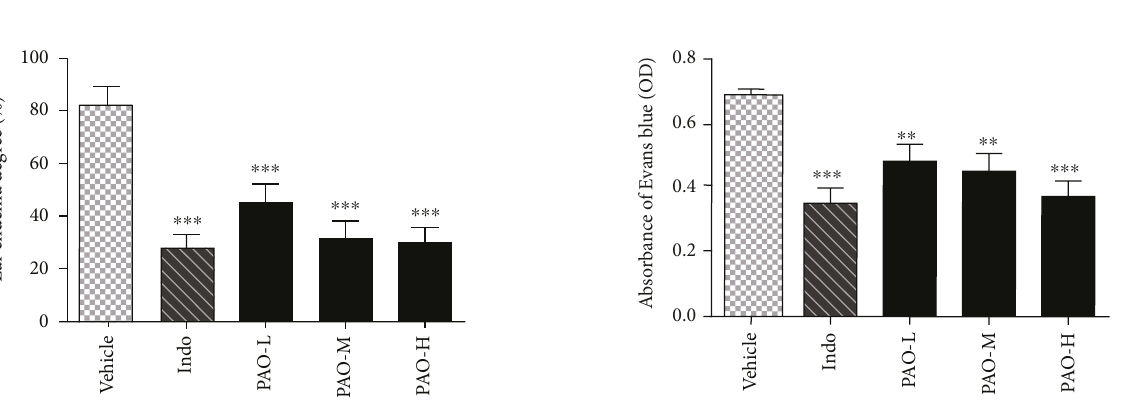
Figure 4: Anti-in fl ammatory e ff ect of PAO on acetic acid-induced vascular permeability in mice. Indo: indomethacin (10mg/kg); PAO-L: low dose of PAO (10mg/kg); PAO-M: medium dose of PAO (20mg/kg); PAO-H: high dose of PAO (40mg/kg). The peritoneal vascular permeability was represented by the amount of Evans blue leaked into the abdominal cavity and measured by the absorbance of the supernatant at 590 nm. Data were expressed as means ± SEM. ( n = 10 ), ∗∗ p < 0 01 , and ∗∗∗ p < 0 001 versus the vehicle group.